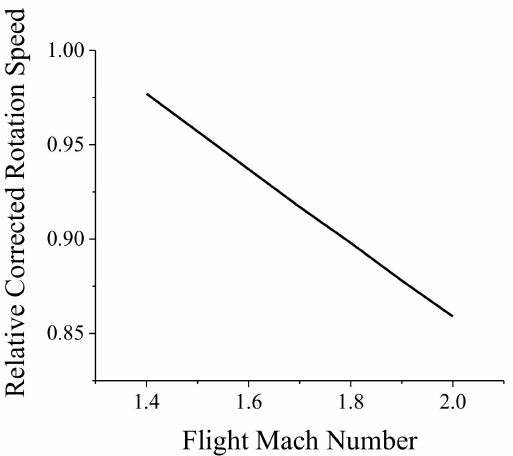
Figure 2. Relative Corrected Rotation Speed of Front Fan vs. Flight Mach Number.